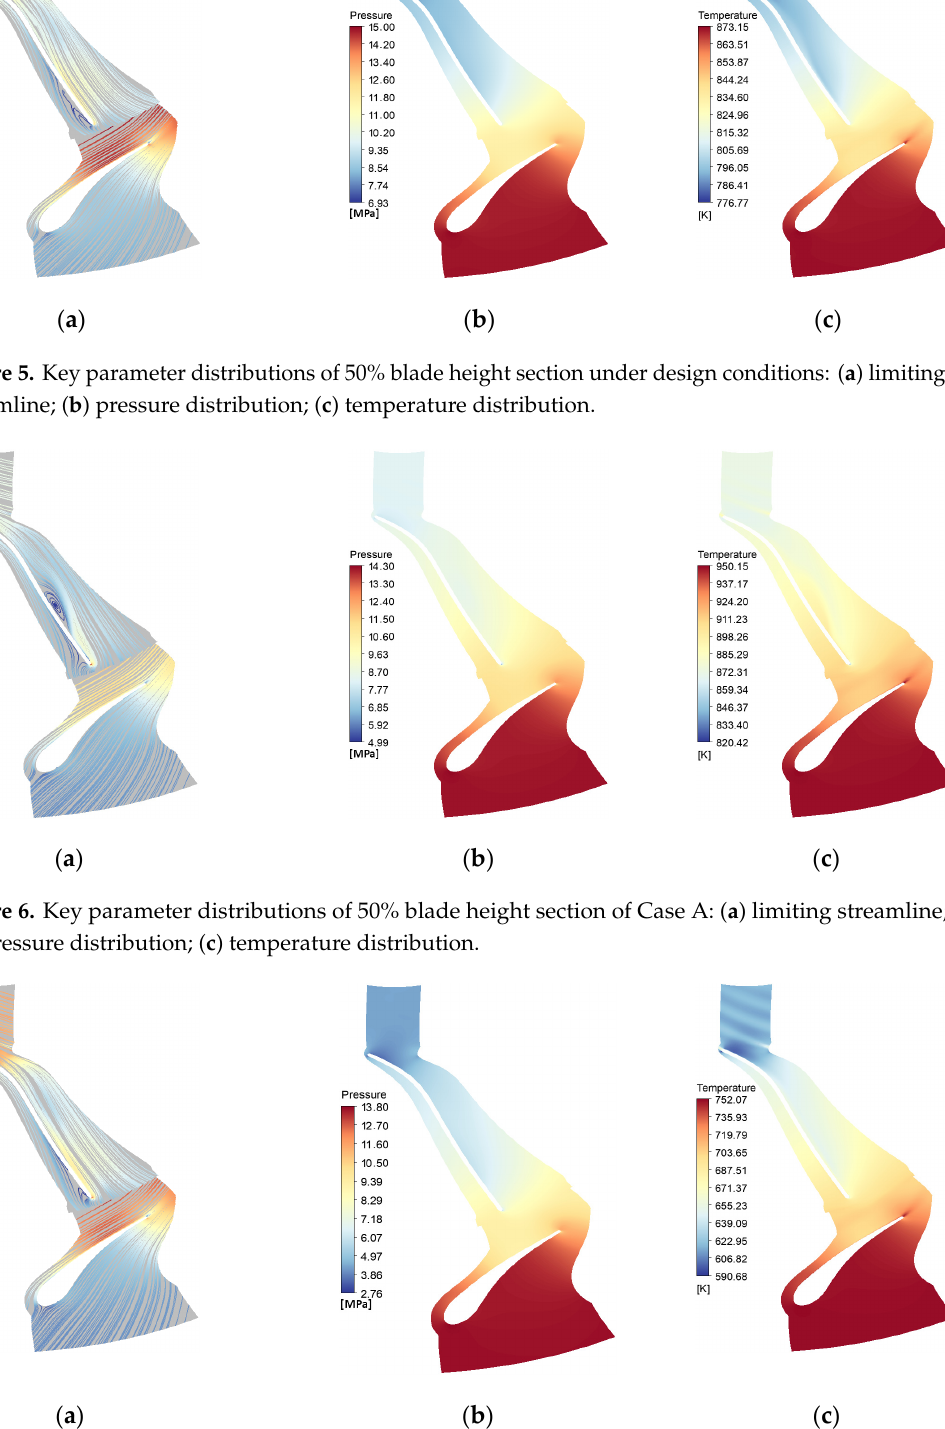
Figure 7. Key parameter distributions of 50% blade height section of Case B: ( a ) limiting streamline; ( b ) pressure distribution; ( c ) temperature distribution.